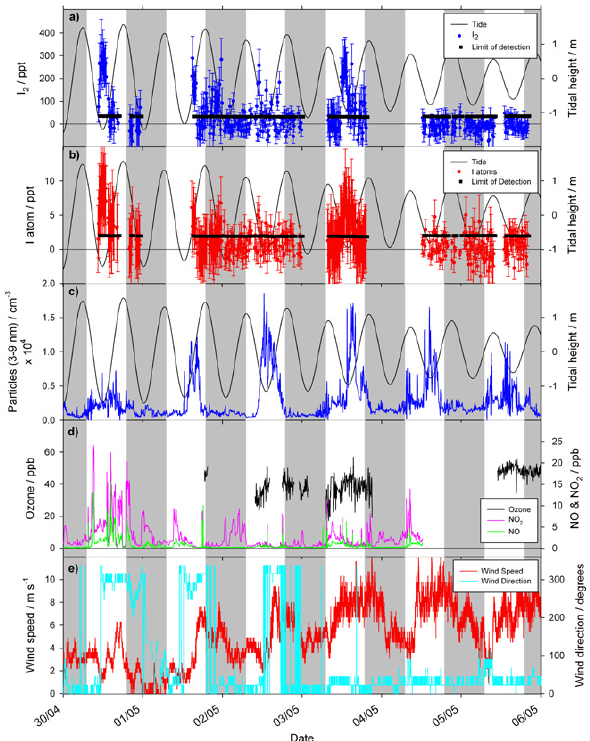
Fig. 2. Time series of measurements made during the LEGOLAS study. Panels (a) , (b) and (c) indicate the I 2 , I and ultrafine particle observations along with the tidal variation. Panel (d) shows the O 3 , NO and NO 2 observation, while the wind speed and direction is shown in panel (e) . Night time is